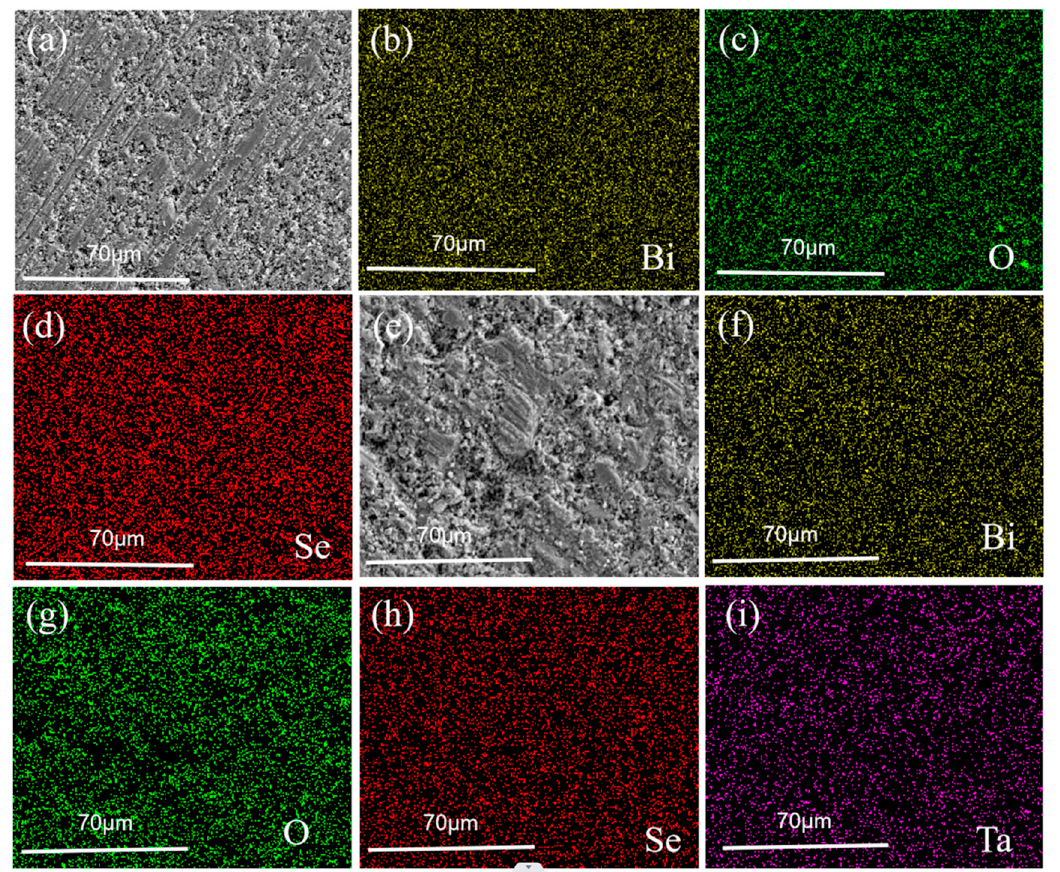
Figure 2. SEM image and EDS elemental mapping images of Bi 2 O 2 Se ( a – d ) [32] and Bi 1.94 Ta 0.06 O 2 Se ceramics ( e – i ).